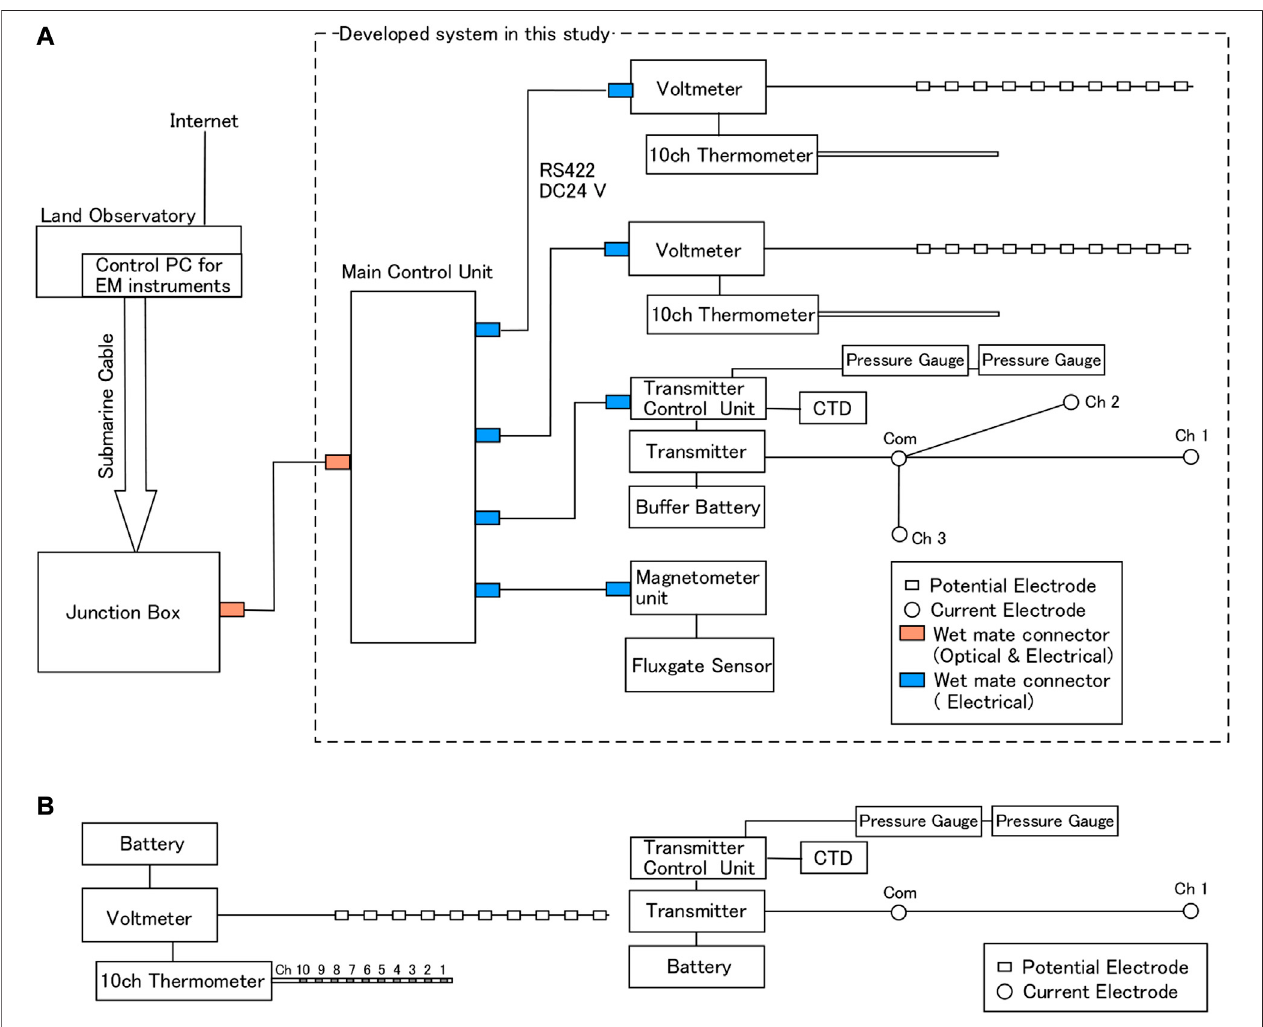
FIGURE 1 | (A) Original system con fi guration of the monitoring resistivity and self-potential (surrounded by the dashed square) planned for connection with the cabled observatory system. The main control unit connects to the junction box of the backbone cable system via an electrical/optical wet mate underwater connector. The main control unit has four electrical wet mate connectors to communicate with observation units. (B) Modi fi ed system con fi guration for a stand-alone experimental observation.